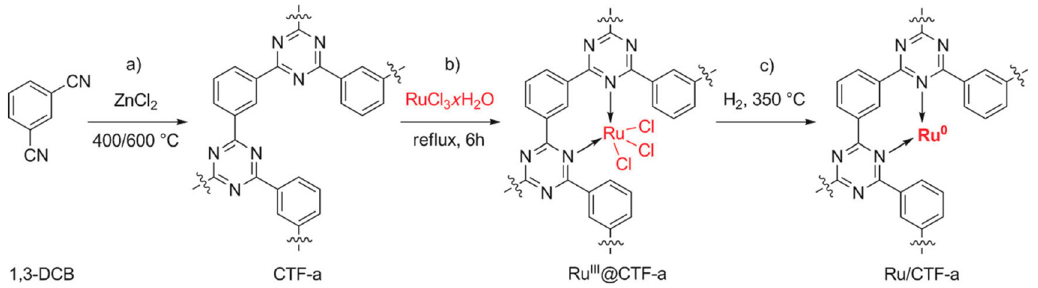
Scheme 4. Schematic representation of the coordination and stabilization of Ru NPs onto CTF material (Reproduced with permission from [34]. Copyright 2015, Wiley-VCH).